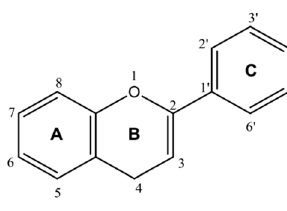
Figure 5. Flavan core of flavonoids.